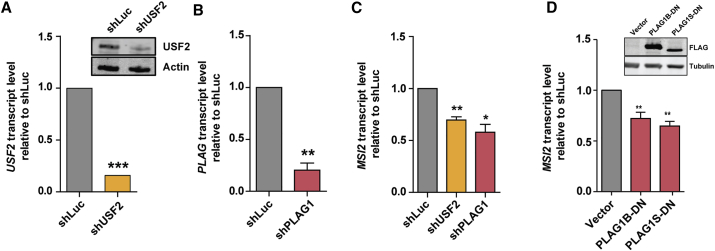
PLAG1 and USF2 Are Required for MSI2 Promoter Activity and Expression(A and B). Knockdown efficiencies of shUSF2 (E) and shPLAG1 (F) as measured post-infection by q-RT-PCR and western blot where sufficient cells were available (inset, A) in K562 cells (n = 3 experiments for each hairpin).(C) MSI2 transcript level reductions following USF2 and PLAG1 knockdown (n = 3 experiments).(D) Western blot (inset) validation of overexpression of the dominant-negative forms of PLAG1-B (PLAG1B-DN) and PLAG1-S (PLAG1S-DN), and graph of MSI2 transcript levels following introduction of PLAG1B-DN or PLAG1S-DN into K562 cells. (n = 3 experiments).Data are presented as means ± SEM. ∗p < 0.05, ∗∗p < 0.01, ∗∗∗p < 0.001. See also Table S3.